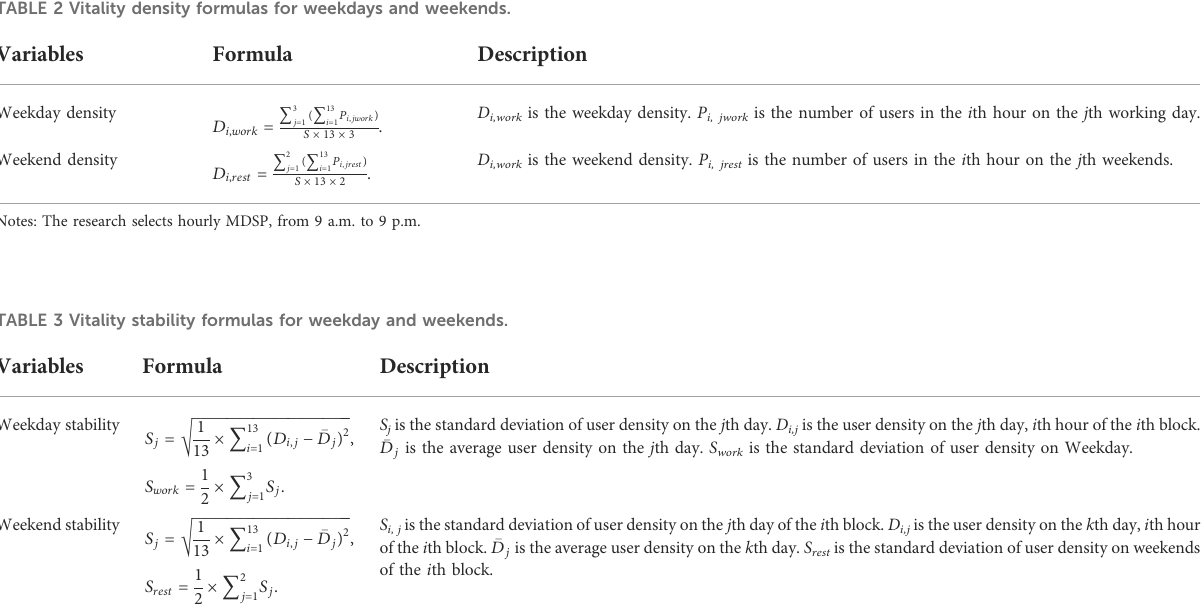
TABLE 2 Vitality density formulas for weekdays and weekends.